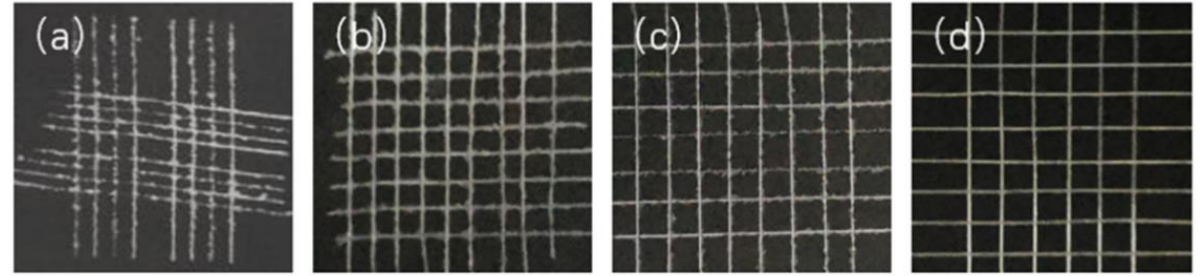
Figure 7. Typical adhesion images of ( a ) DLC-F, ( b ) 2K-CERA., ( c ) PUD, ( d ) 2W-WPU. The 2K-WPU coating shows the best adhesion as ISO class 0/ASTM class 5B, while both the 2K-ceramic coating and PUD present ISO class 1/ASTM class 4B adhesion. In contrast, DLC-F shows the worst grade with ISO class 3/ASTM class 3B adhesion. We expected that the 2K-ceramic coating would exhibit good adhesion due to its good optical performance, but the result seems contrary. The low adhesion level would cause the